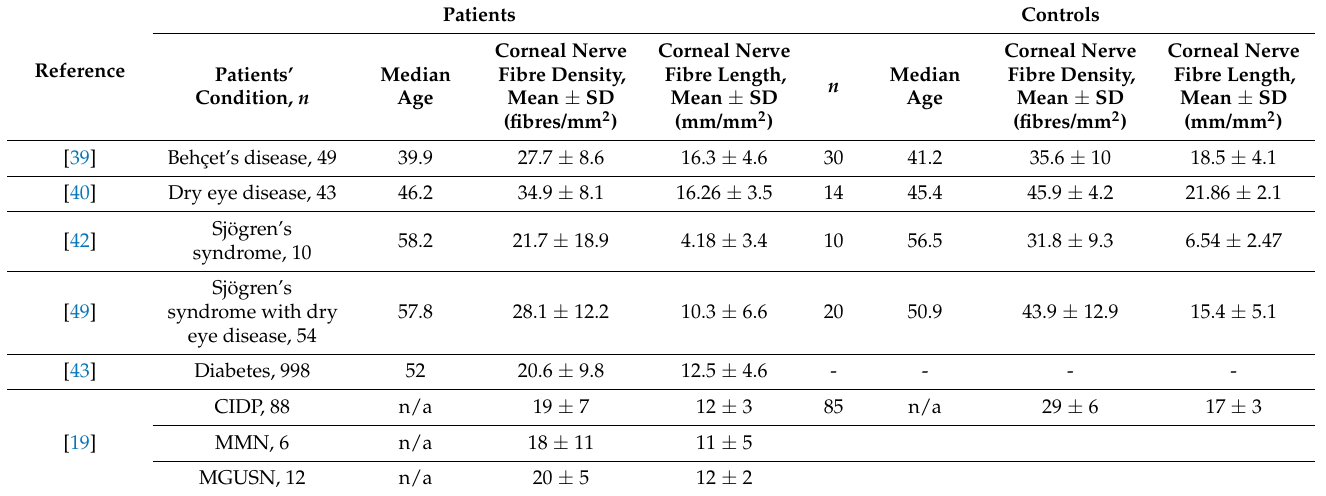
Table 5. Literature review on published data concerning corneal confocal microscopy parameters in different